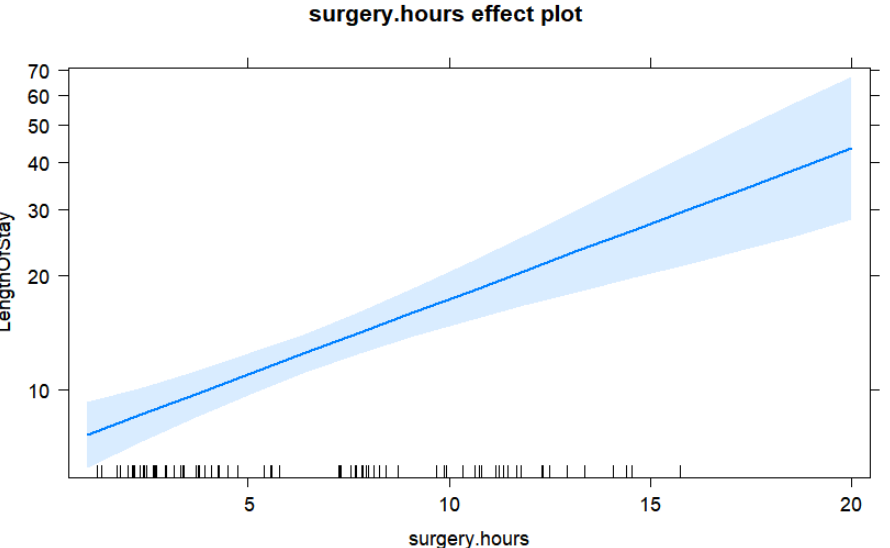
Figure 2. Effect plot for the length of surgery in hours prediction from the final Gamma regression model for the length of stay response.